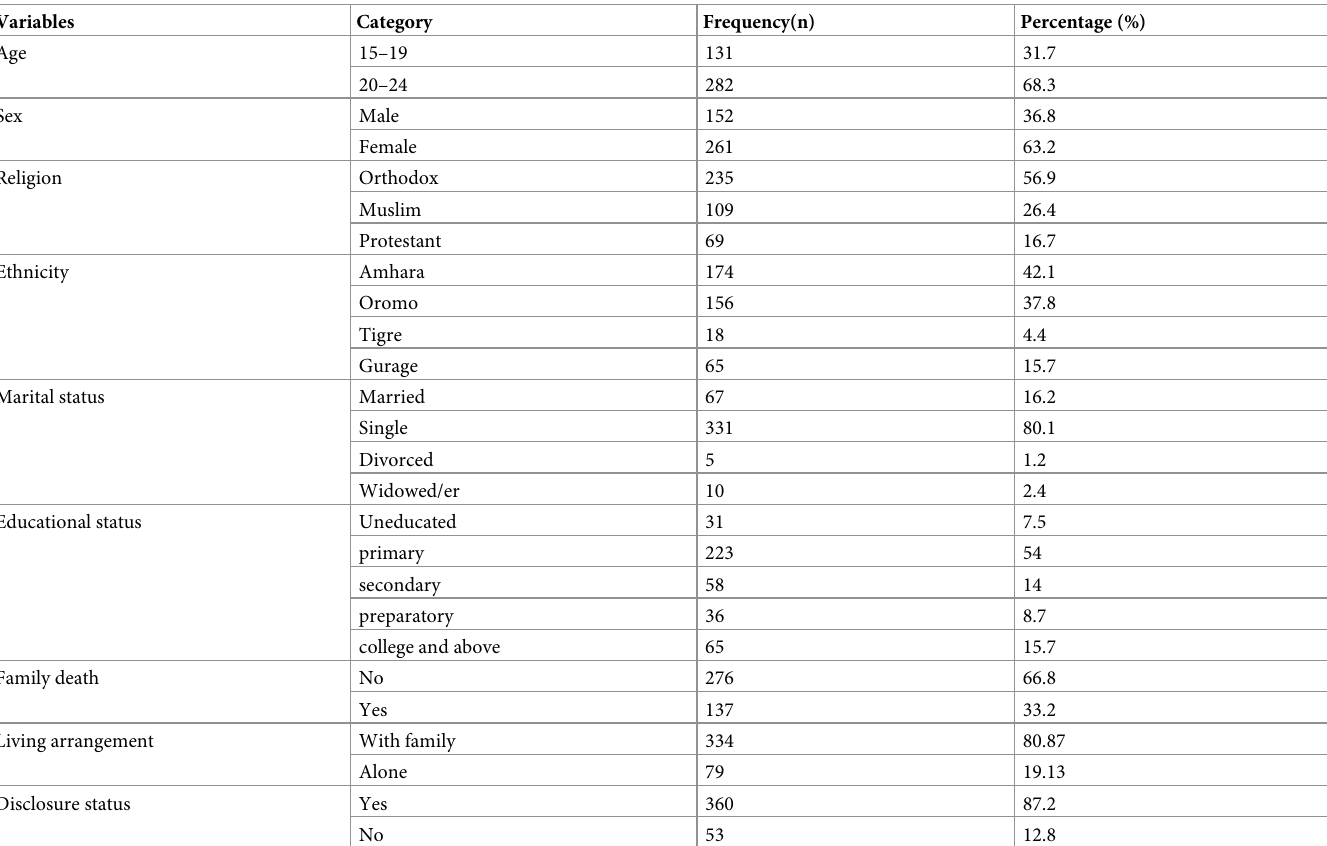
Table 1. Sociodemographic characteristics of HIV positive youth follow up at SPSH and SPHMMC Addis Ababa, Ethiopia, 2018 (n =